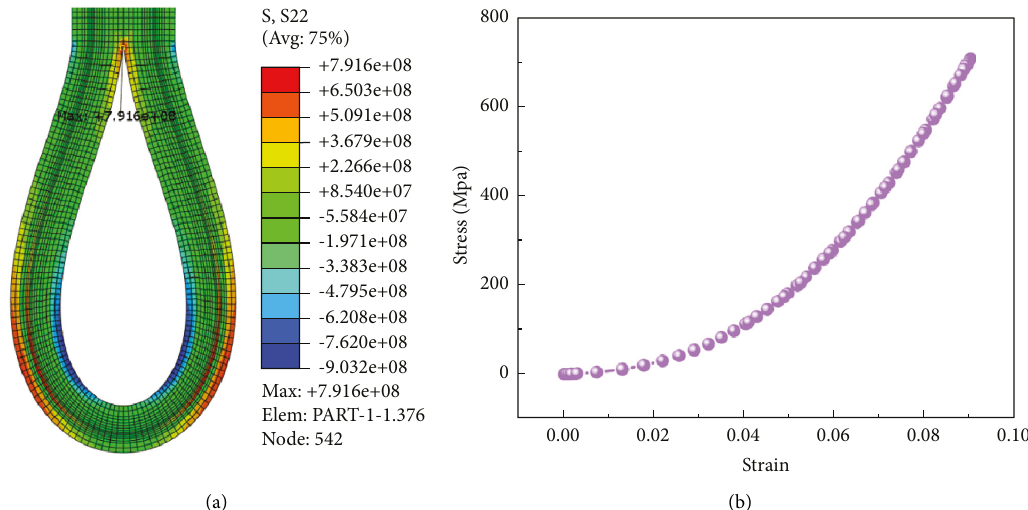
Figure 8: (a) Place where the stress of the water drop bend model s22 is the greatest and (b) the stress and strain diagram of the module at the maximum point of